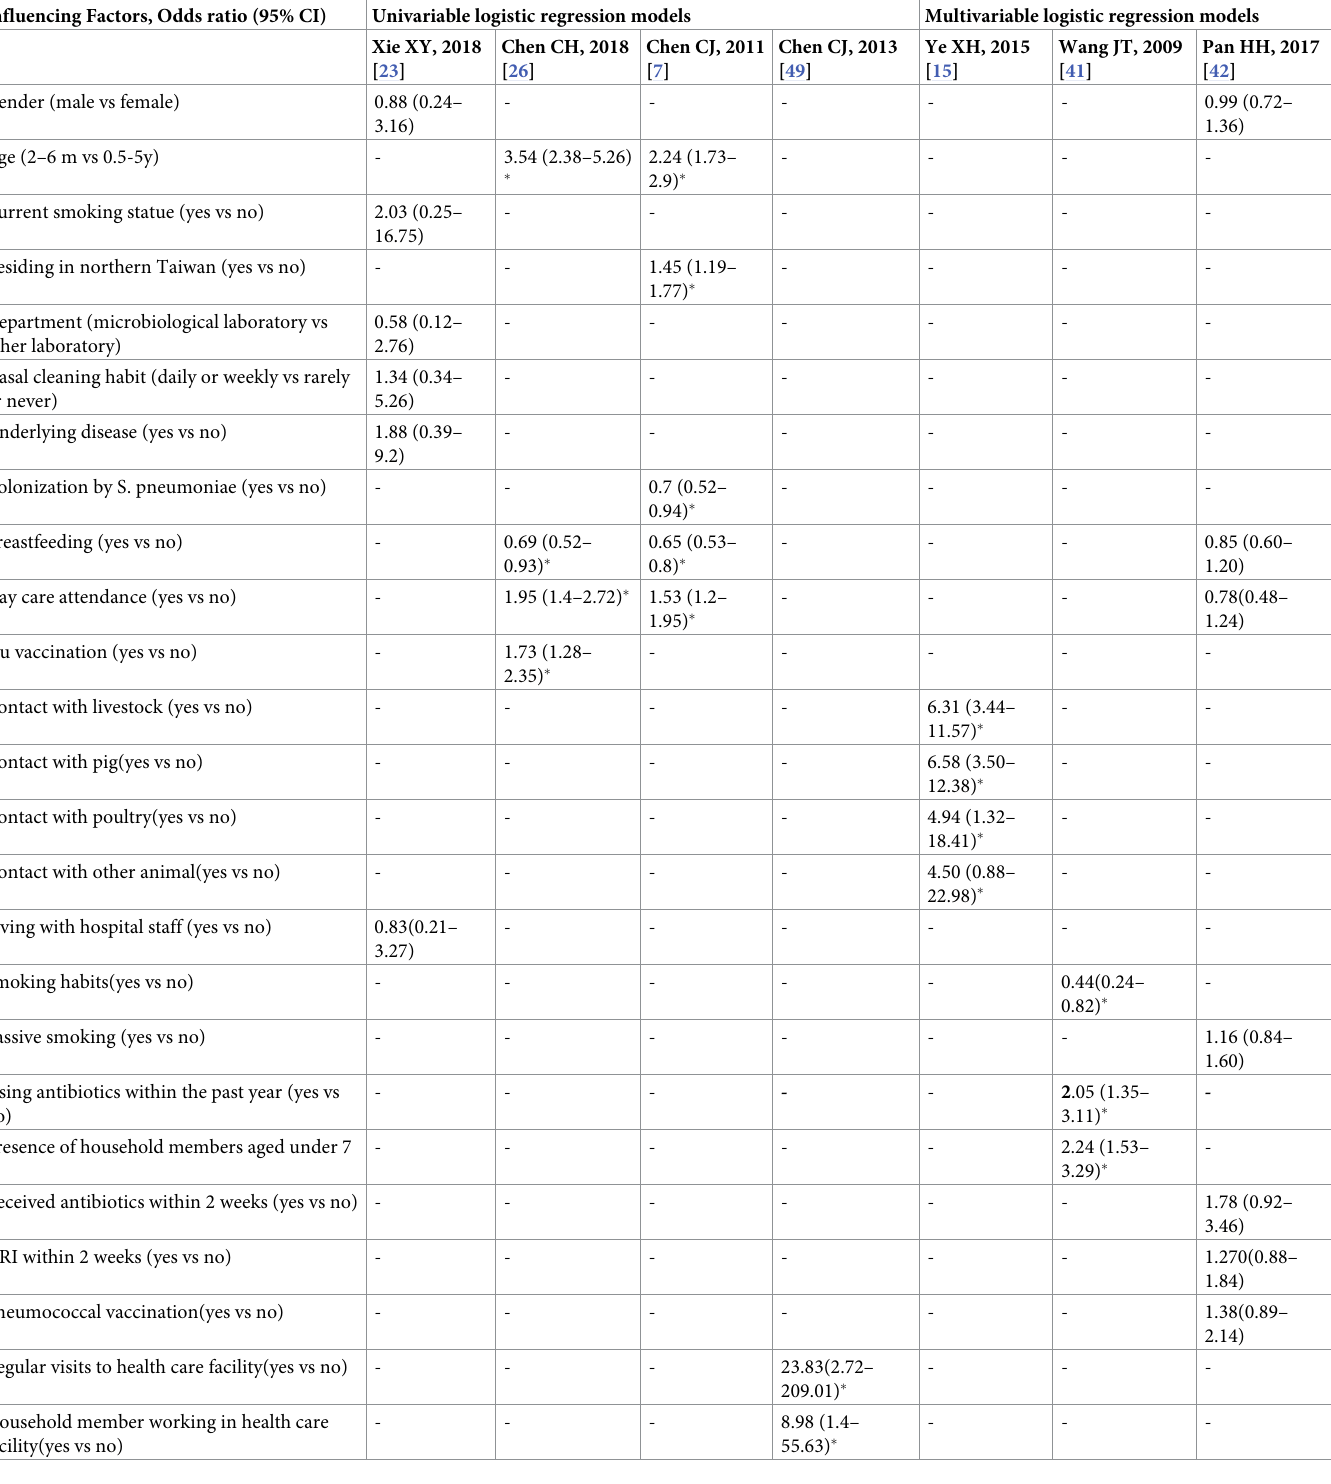
Table 4. Risk factors of MRSA nasal carriage in healthy Chinese population reported in the selected